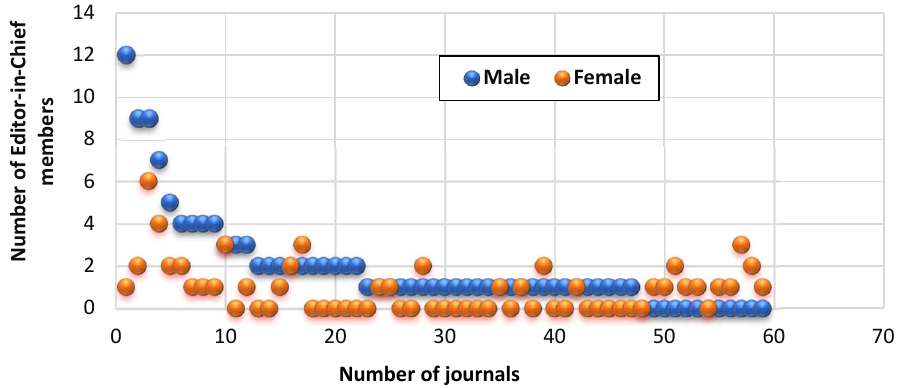
Figure 3. Gender contributions in Editor-in-Chief in each selected LS journal.